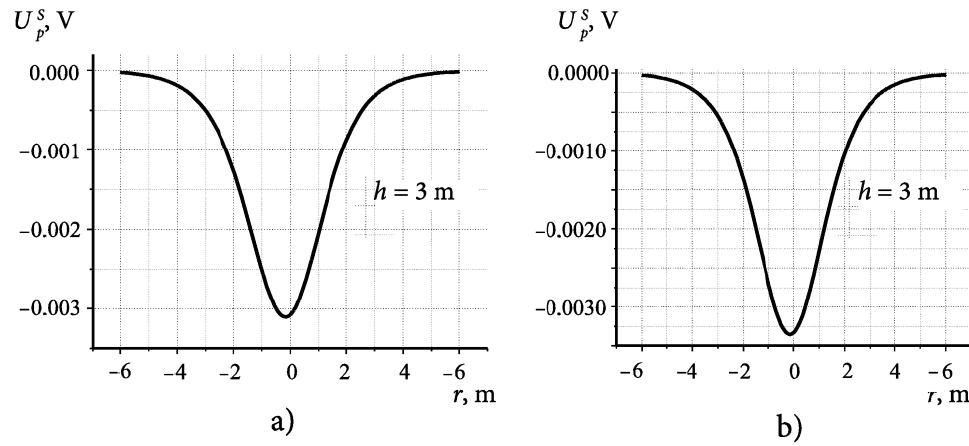
Figure 4. The flow characteristic: ( a ) — corresponds to the free space for H =∞, h =1.5 m; ( b ) — the flow characteristic for H = 6 m, h = 1.5 m.